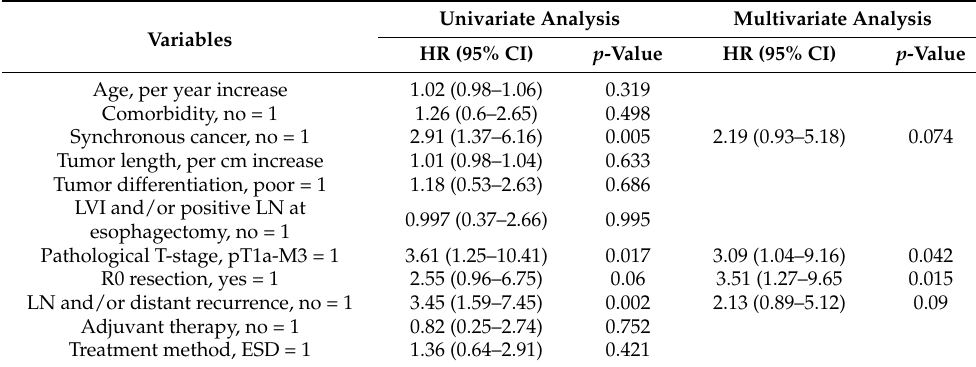
Table 3. Univariate and multivariate analyses of overall survival for all patients.